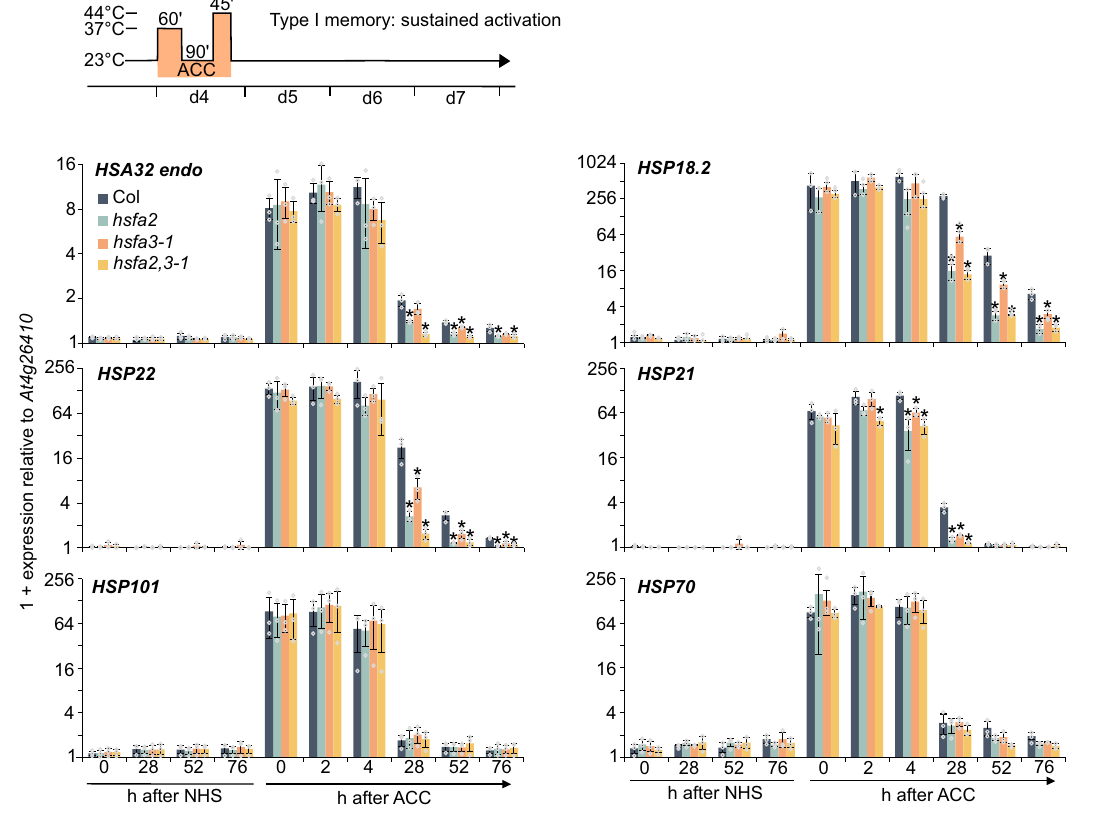
Fig. 4 Sustained induction of HS memory genes depends on HSFA2 and HSFA3 . Type I transcriptional memory (sustained induction): Memory gene expression is induced by a priming ACC treatment and expression is sustained above baseline for several days. Plants were exposed to an ACC treatment and samples taken at the indicated time points during the following 76 h. Relative transcript levels of 4 memory genes ( HSA32 , HSP18.2 , HSP22 , HSP21 ) and 2 HS-inducible non-memory genes ( HSP101 and HSP70 ) were measured by qRT-PCR. Time points depict hours after end of ACC. Data are mean ± SD of three independent experiments. Asterisks mark signi fi cant differences to Col ( p < 0.01, unpaired two-sided